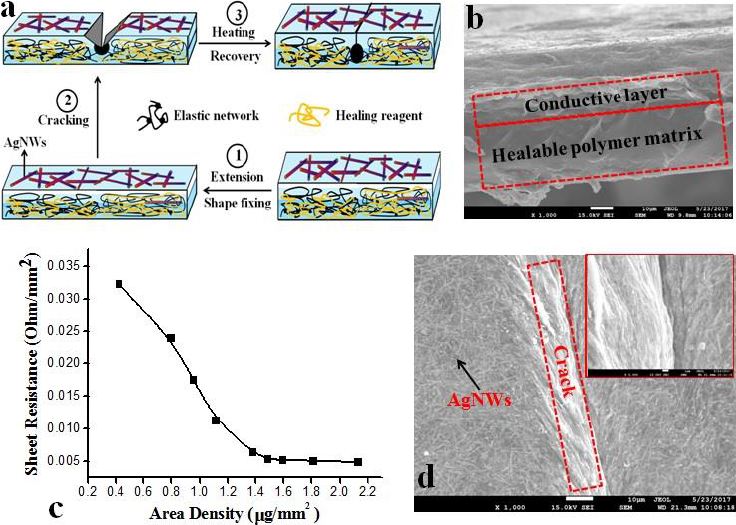
Figure 1. ( a ) Schematic illustration of the shape memory-enhanced self-healable electrode; ( b ) Scanning Electron Microscope (SEM) image of the electrode cross section; ( c ) The plot of the sheet resistance against the AgNWs loads. ( d ) SEM image of the surface morphology with micro-scale scratch.